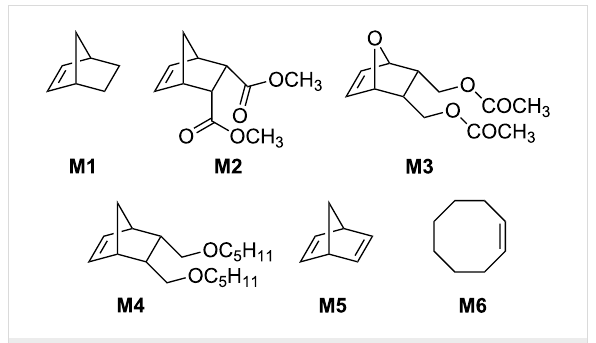
Selected bond lengths are summarized in Table 1. For purposes